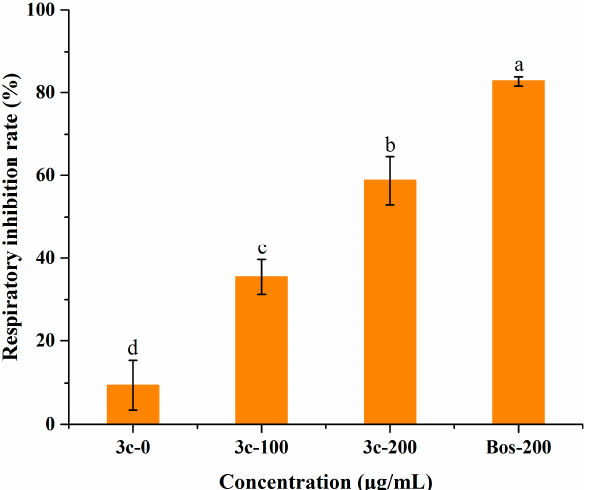
Figure 5. Evaluation of the respiratory inhibition rate on B. cinerea mycelia exposed to compound 3c and the commercial respiration inhibitor boscalid (BOS). Different letters among treatments mean statistically significant differences using Tukey’s test ( p < 0.05).